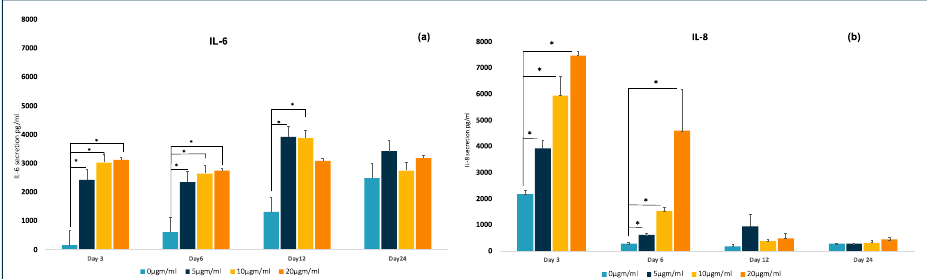
Figure 6. Effects of LPS on cytokine secretion profile of 3D PDLSCS. Cells were cultured under osteogenic induction and with LPS at different concentrations for different time intervals. Graphical representation of ( a ) IL-6 and ( b ) IL-8 secretion by 3D PDLSCs. The values of three independent experiments are presented as means ± SD. * p ≤ 0.05 .